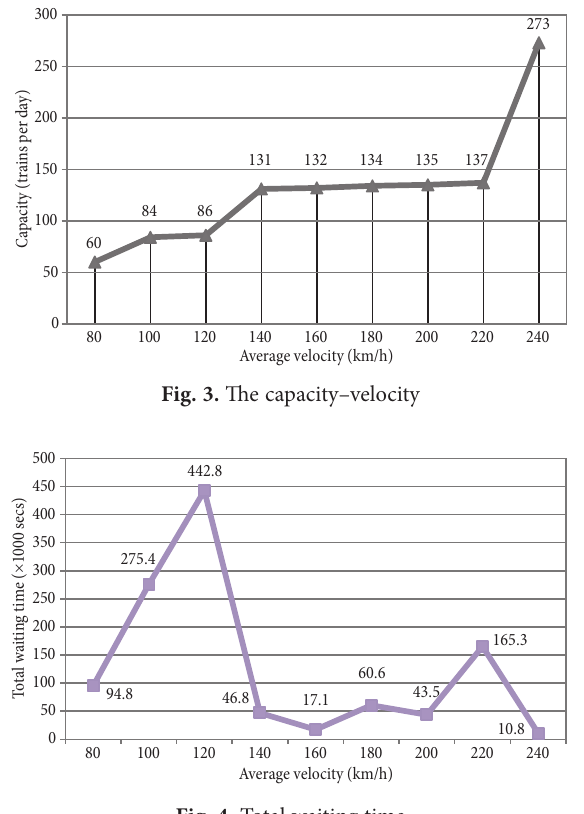
Fig. 4. Total waiting